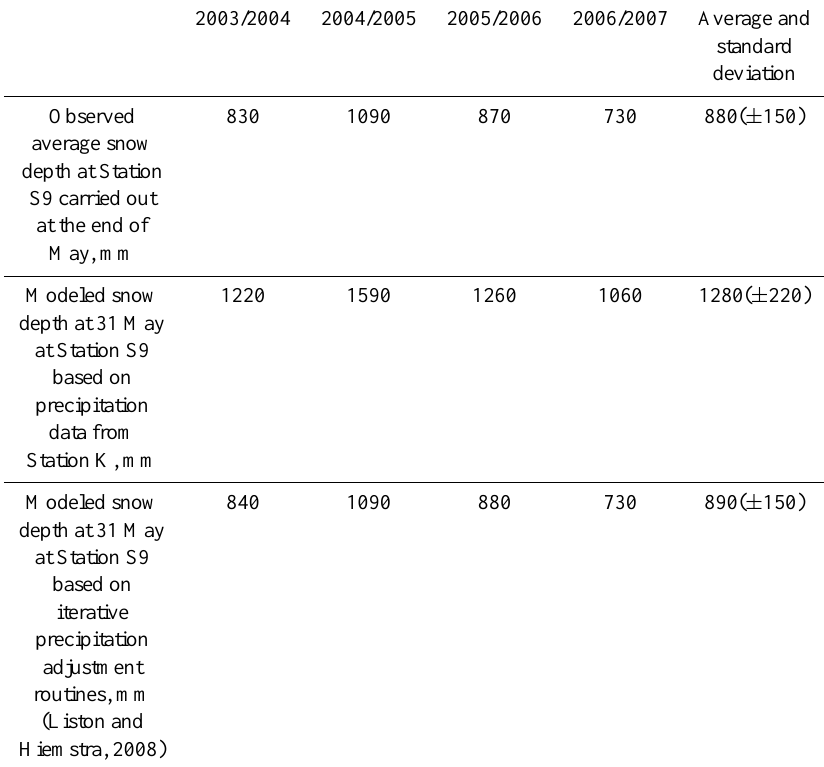
Table 3. Observed and modeled snow depth for Station S9 at the end of winter (31